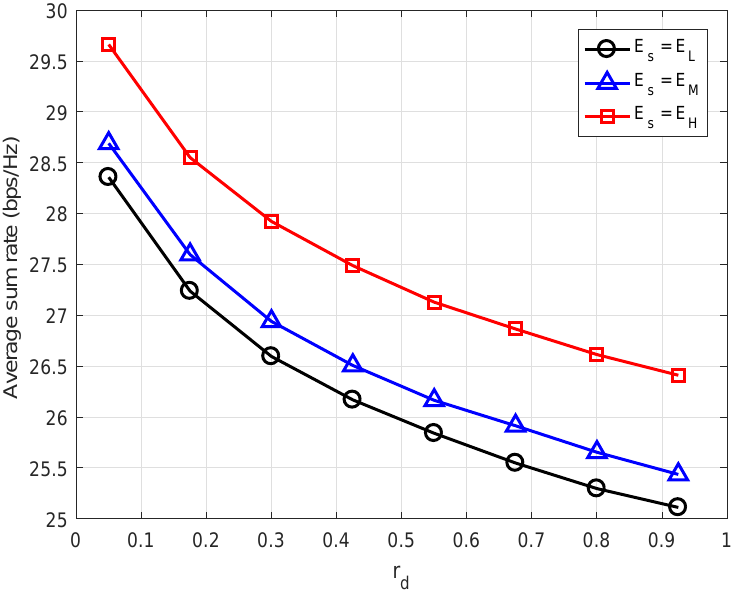
Figure 6. Impact of the relay position on the average sum rate performance for different values of energy harvesting (EH) profiles with d SR + d RD = 2